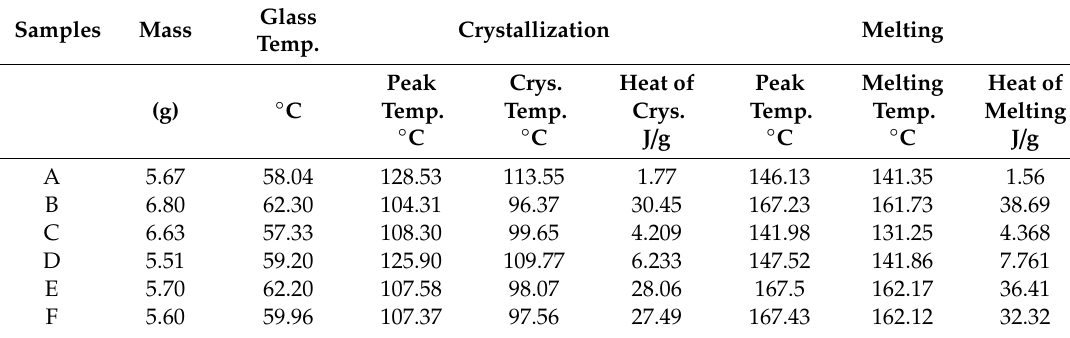
Figure 7. DSC plot of samples A—92% polylactic acid (P)/8% chitin (C); B—92% P/6% C/2% starch (S); C— 92% P/4% C/4% S; D—92% P/2% C/6% S; E—92% P/8% S; F—100% P. Table 1. Summary of the results for di ff erential scanning calorimetry